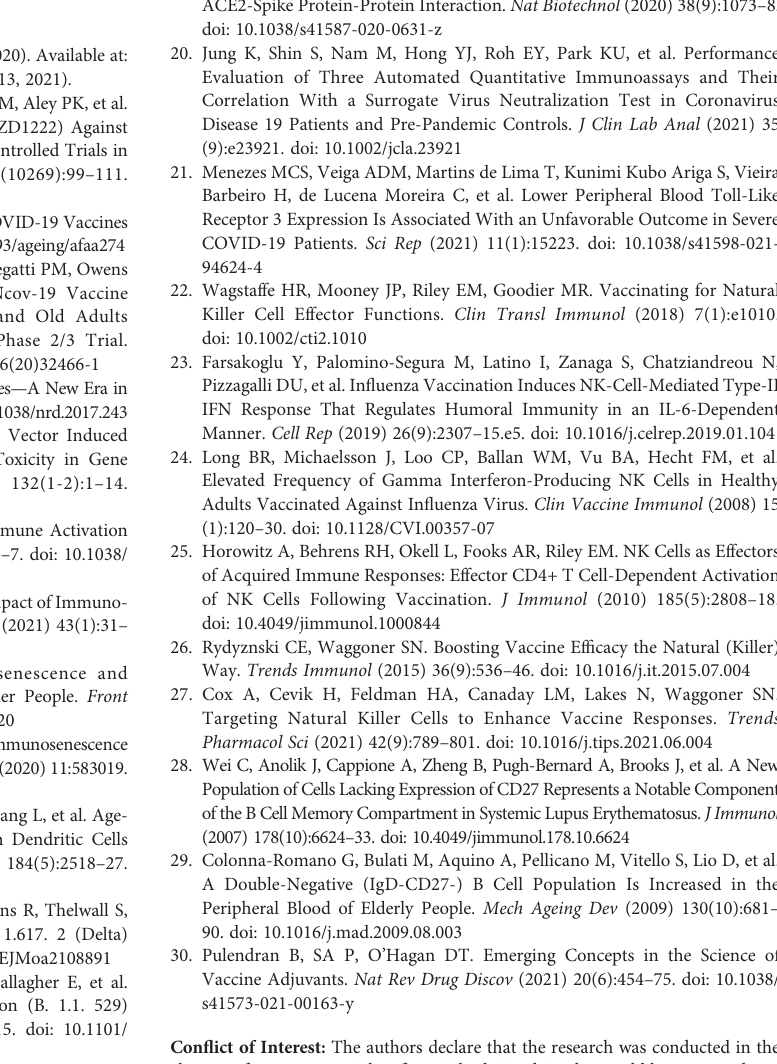
Supplementary Figure 1 | Cytokine-producing NK and monocyte 3 days after ChAdOx1 nCoV-19 vaccination. PBMCs were isolated from young (black bars) and older adult vaccinees (gray bars) 3 days after the fi rst and second vaccinations. The percentage of IFN- g - (A) and granzyme B- (B) expressing cells in CD3-CD56dim or CD3-CD56brightNK cells; IL-6-, IL-10-, and IFN- a -